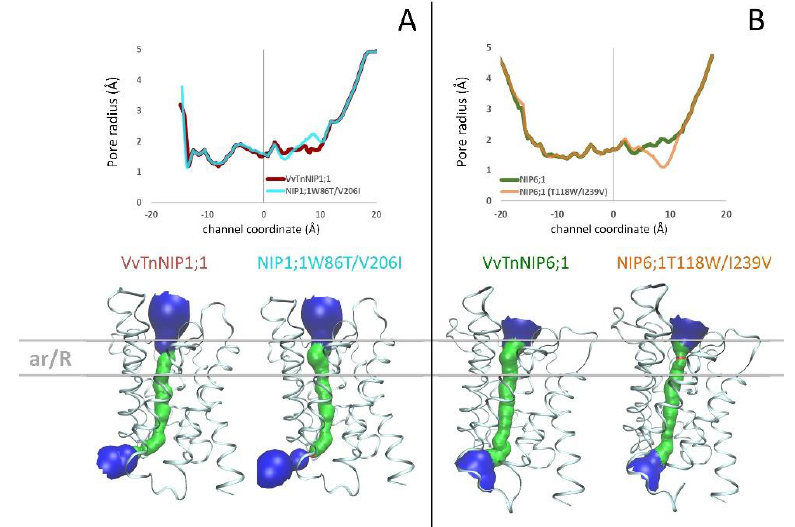
Figure 4. ( A ) Pore radius profiles of native VvTnNIP1;1 (red line) and of double mutant NIP1;1W86T / V206I (cyan line) are shown in the upper panel; 3D structures and pore surfaces of VvTnNIP1;1 and of NIP1;1W86T / V206I in the bottom panel. ( B ) Pore radius profiles of native VvTnNIP6;1 (green line) and of double mutant NIP6;1T118 / I239V (orange line) are shown in the upper panel; 3D structures and pore surfaces of VvTnNIP6;1 and of NIP6;1T118W / I239V in the bottom panel.